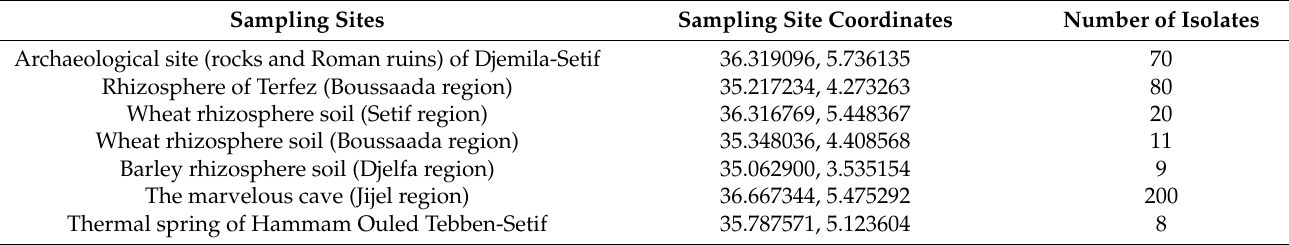
Table 2. Number of bacterial isolates recovered from different sampling